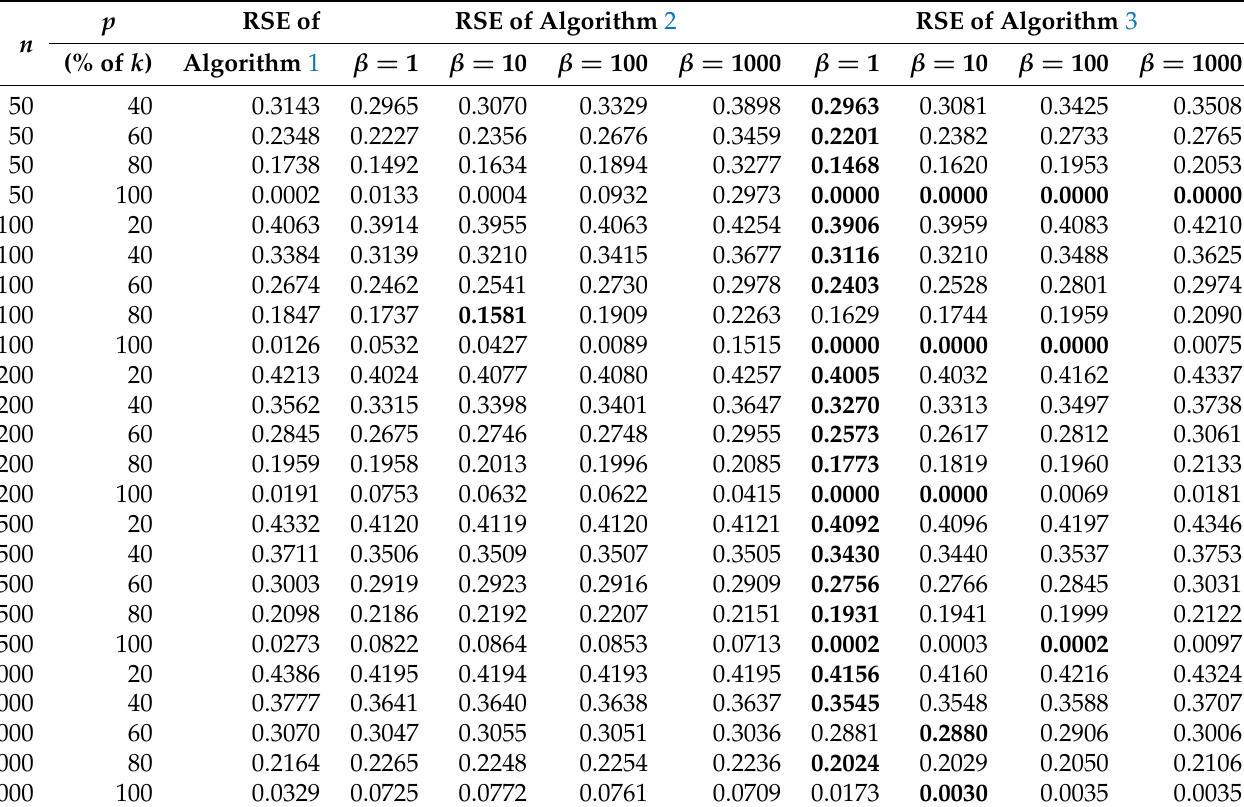
Table 2. In this table we demonstrate how good RSE is achieved by Algorithms 1–3 on UNION dataset. For each n ∈ { 50,100,200,500,1000 } we take all 10 matrices R (five of them corresponding to k = 0.2 n and five to k = 0.4 n ). We run all three algorithms on these matrices with inner dimensions p ∈ { 0.2 k ,0.4 k , . . . ,1.0 k } with all possible values of β ∈ { 1,10,100,1000 } . Each row represents the average (arithmetic mean value) RSE obtained on instances corresponding to given n . For example, the last row shows the average value of RSE in 10 instances of dimension 1000 (five of them corresponding to k = 200 and five to k = 400) obtained by all three algorithms for all four values of β , which were run with the input dimension p = k . The bold number is the smallest one in each line.